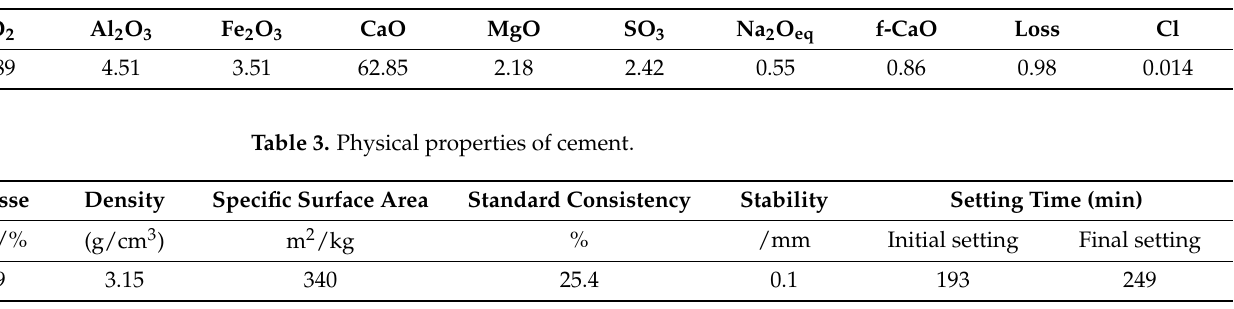
Table 2. Chemical analysis results of cement (%).